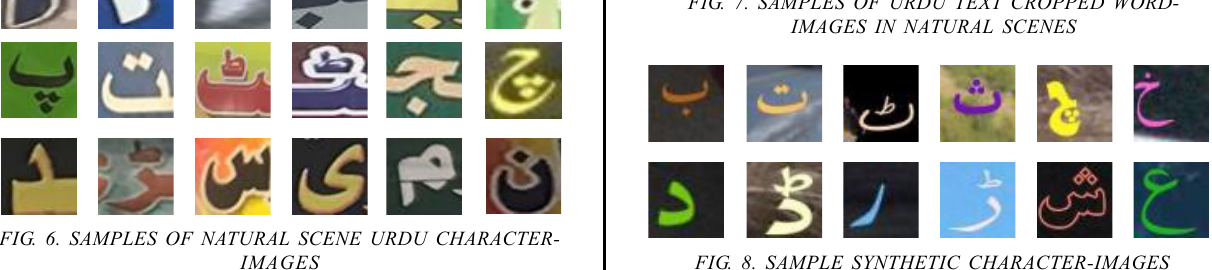
FIG. 8. SAMPLE SYNTHETIC